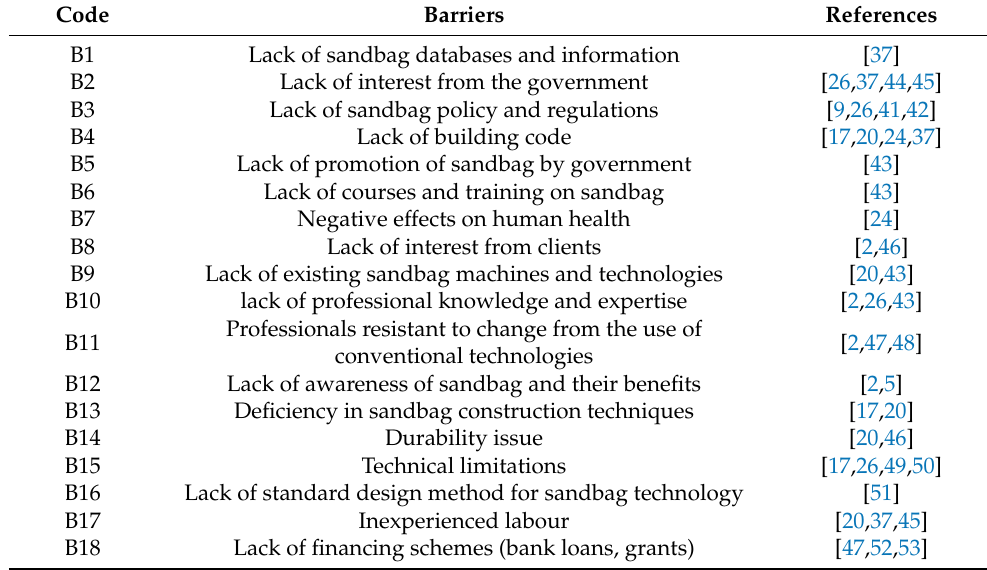
Table 1. Summary of the identified barrier to the social acceptance of sandbag technology. Code